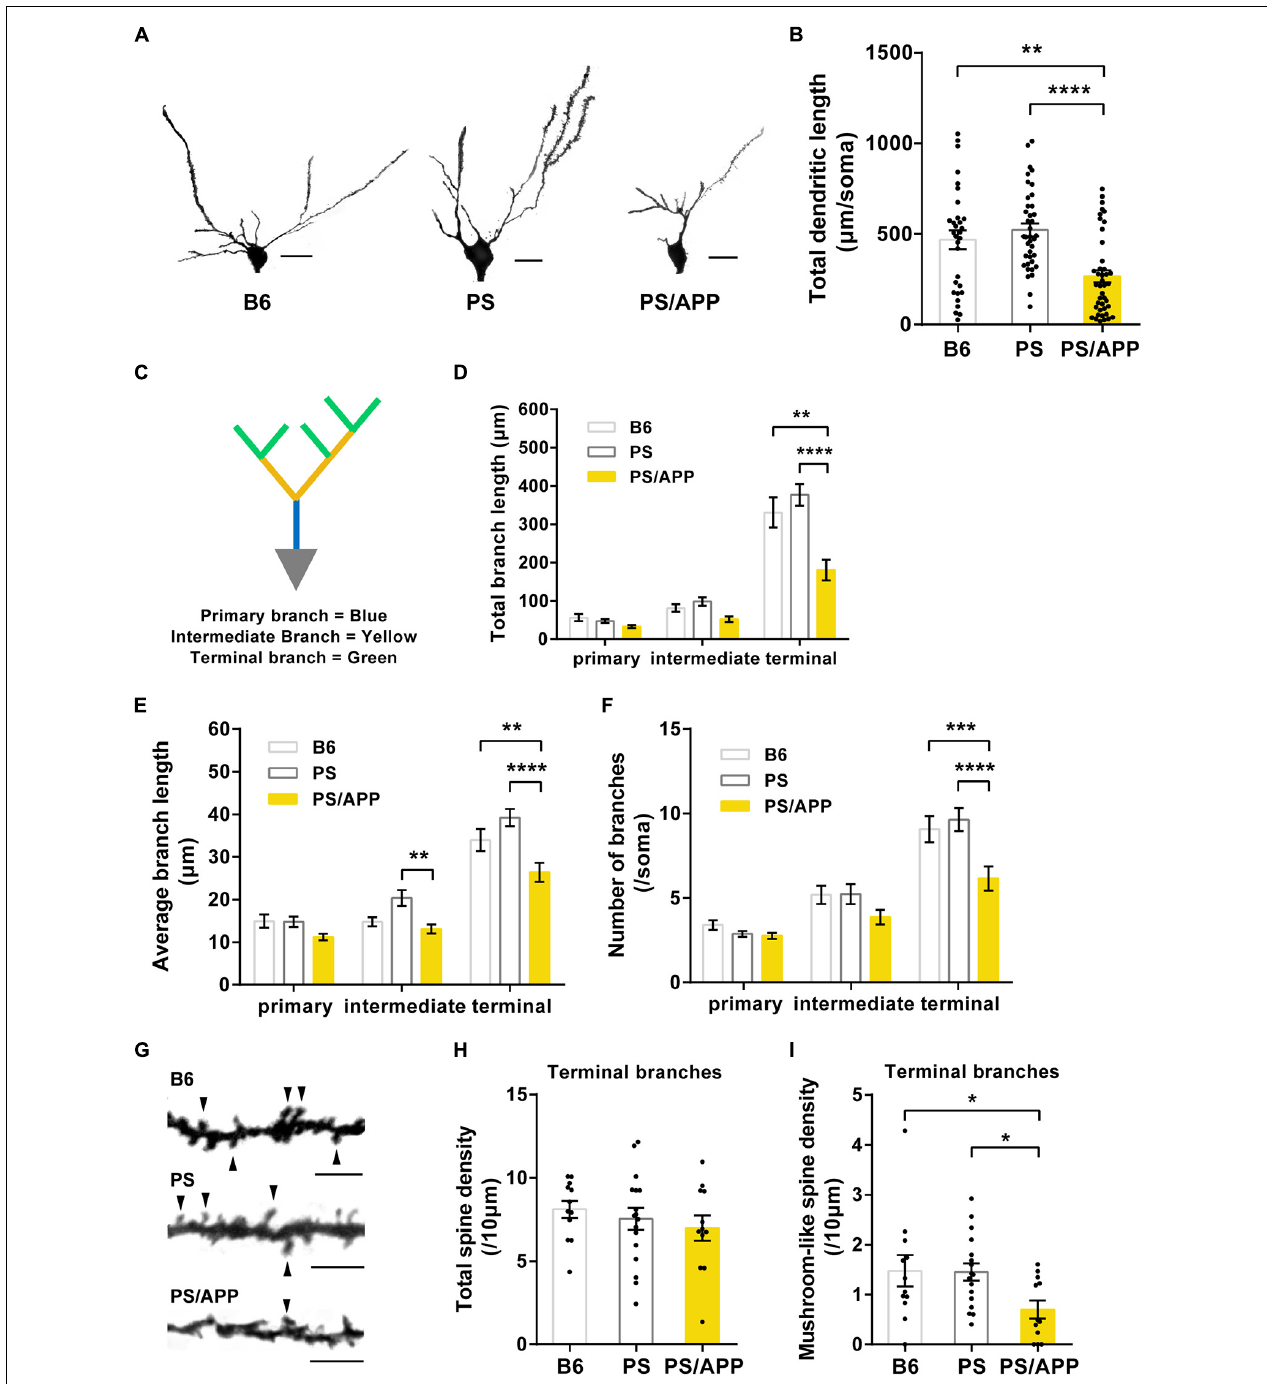
FIGURE 1 | Dendrites and mushroom-like spines were impaired in PS/APP mice. (A) Extracted representative Golgi staining images of CA1 basal dendrites. The scale bar is 20 µ m. (B) Total length of CA1 basal dendrite. In PS/APP mice, total length was significantly decreased compared with B6 and PS mice. (C) An image of a CA1 pyramidal cell depicting the breakdown of the arbor into branch types. (D) Total length of each order of dendrite. PS/APP mice showed a decrease in total length of terminal branches. (E) Average length of each dendritic order. In PS/APP mice, length of intermediate and terminal branches was significantly decreased. (F) Number of branches at each order of dendrite. PS/APP mice showed significant decrease in number of terminal branches. (G) Extracted representative images of spine on basal dendrite. Arrowheads indicate mushroom spines. The scale bar is 5 µ m. (H) Density of total spine on terminal branches. There were no significant changes between all groups. (I) Density of mushroom spines in terminal branches. PS/APP mice showed significant decrease in mushroom-like spines. All data are presented as mean ± SEM. * p < 0.05, ** p < 0.01, *** p < 0.001, and **** p < 0.0001. Dunn’s multiple comparisons test for (B) , two-way ANOVA, followed by Dunnett’s multiple comparisons test for (D–F) , Dunnett’s multiple comparisons test for (H,I) .